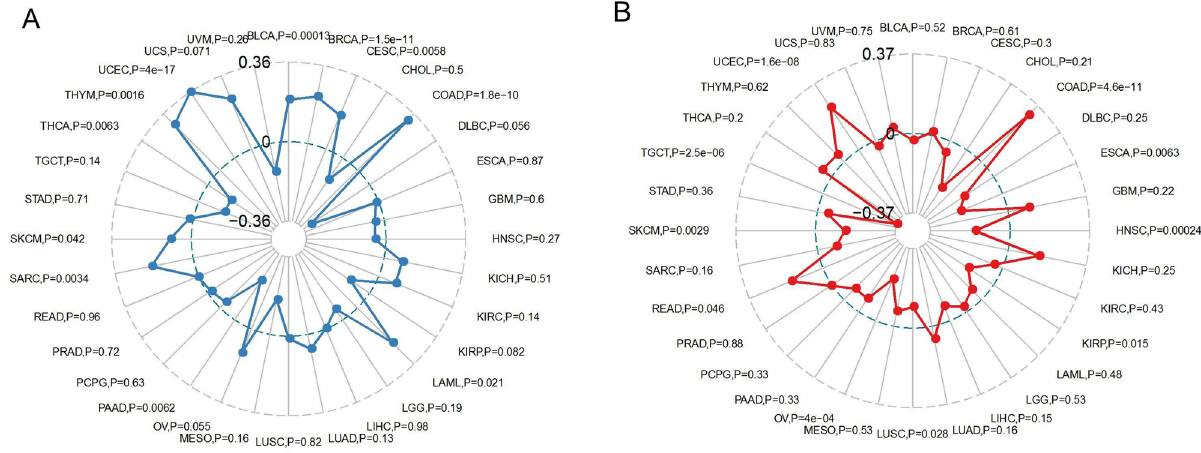
Figure 7. Radar map displaying the correlations between TIGIT expression and Tumor mutation burden ( A ), as well as the correlations between TIGIT expression and microsatellite instability, ( B ) across 33 cancer types.